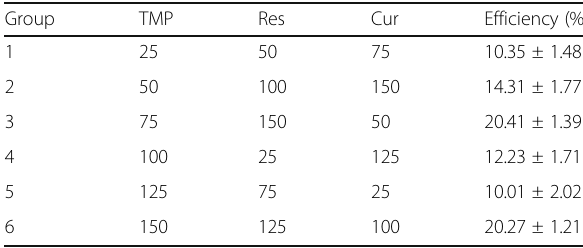
Table 2 Experimental design of the U3 6 and its corresponding